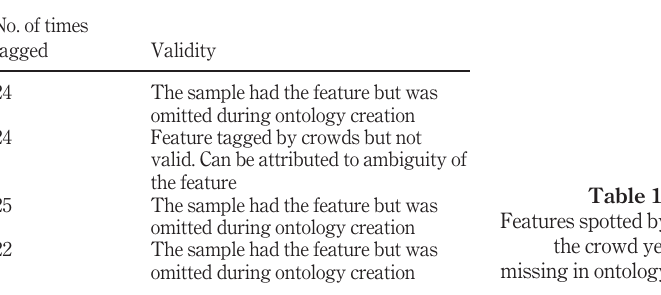
Table 1. Features spotted